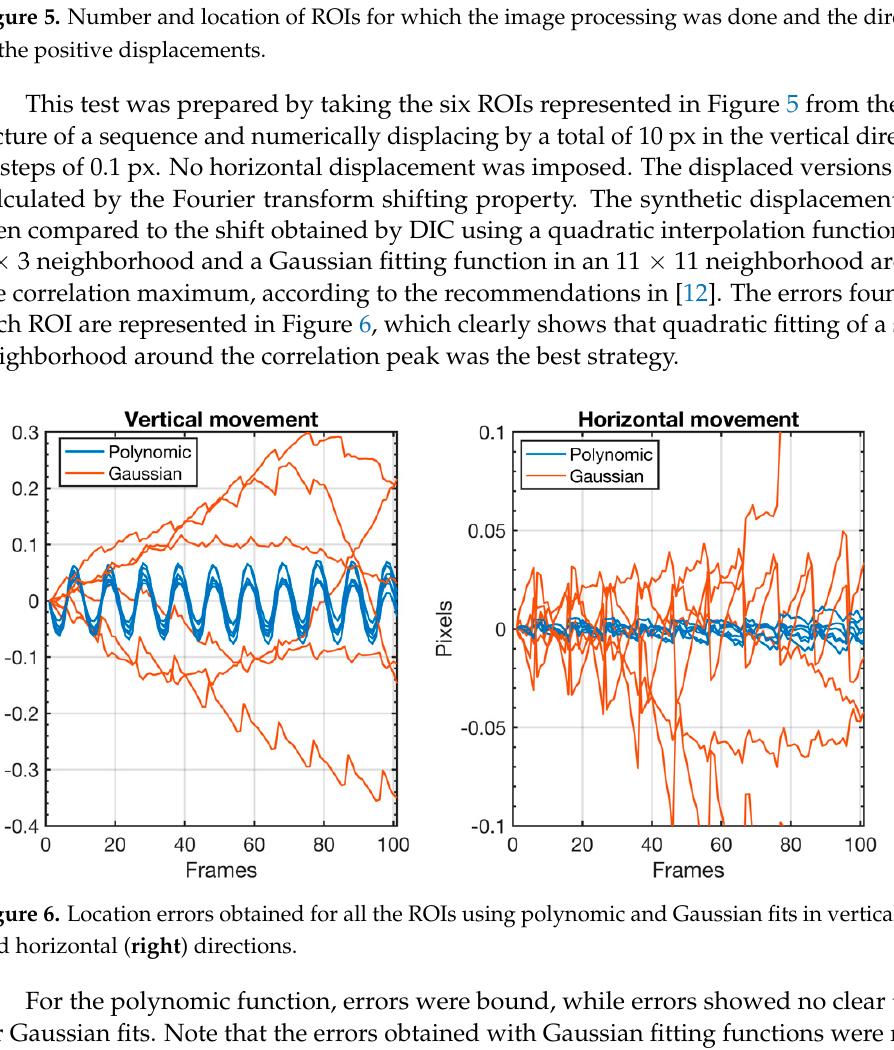
Figure 6. Location errors obtained for all the ROIs using polynomic and Gaussian fits in vertical ( left ) and horizontal ( right ) directions.